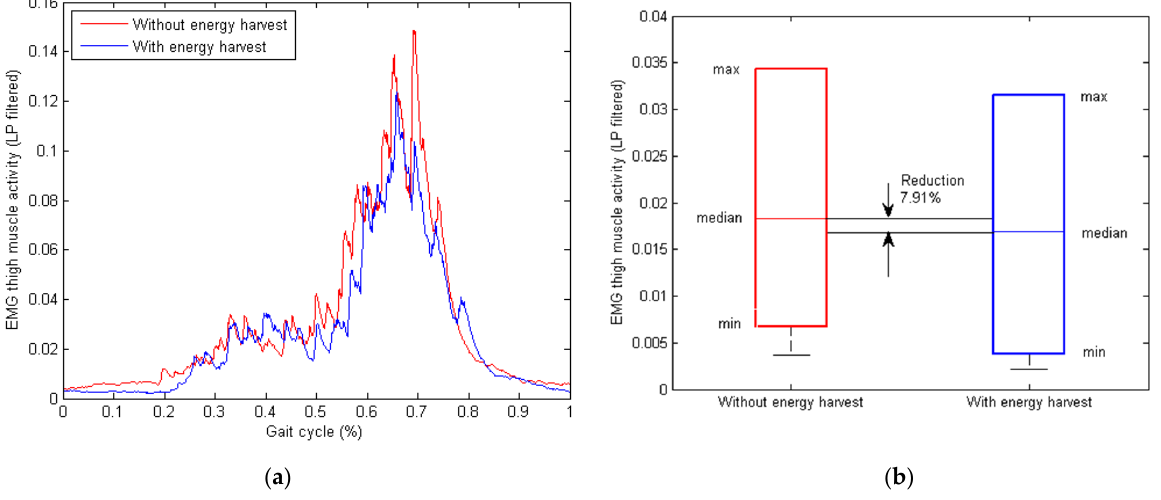
Figure 17. Plot and comparison of the measured EMG thigh muscle activity without and with energy harvesting when the walking speed of the human subject was 1.2 km/h downstairs. ( a ) Comparison of the averaged EMG thigh muscle signal from the experiment in one gait cycle (rectified and low-pass filtered). ( b ) Box plot of the averaged EMG thigh muscle activity from the experiment, where a reduction of 7.91% was observed from the experimental tests.